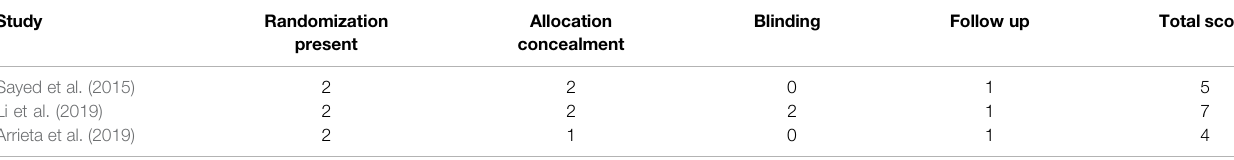
TABLE 2 | Quality evaluation of randomized controlled trials (RCTs) included according to Jadad Score. Study